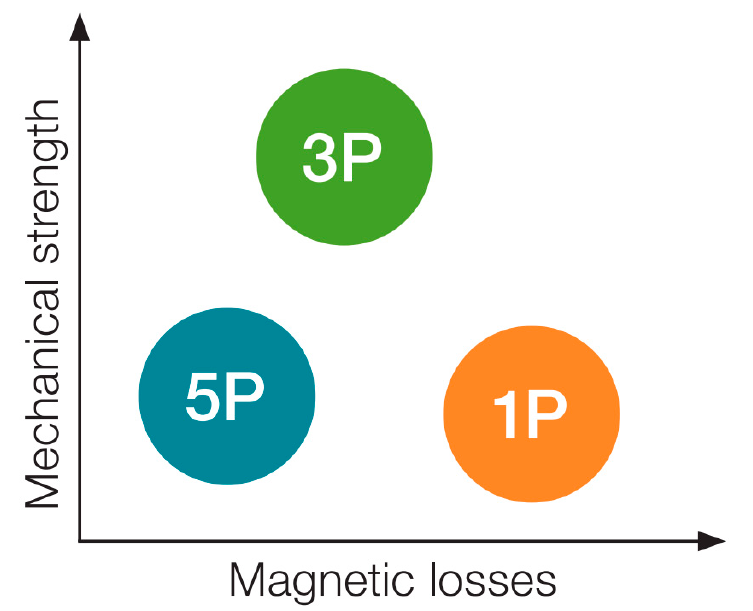
Figure 5. Mechanical strength and magnetic losses of three groups of Höganäs Somaloy SMC mate- rials.